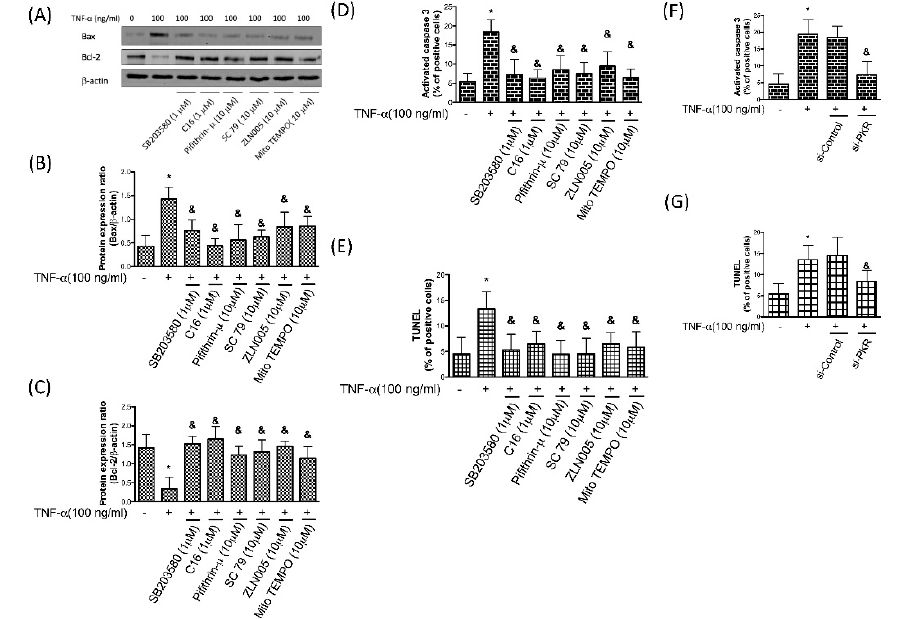
Figure 7. Protein expression ( A ) and ratio of Bax and Bcl2 ( B,C ) after TNF- α treatment in human chondrocytes in the presence of p38 inhibitor SB203580, PKR inhibitor C16, p53 inhibitor Pifithrin- μ , AKT activator SC79, PGC-1 α stimulator ZLN005, or superoxide scavenger Mito TEMPO. Percentages of TNF- α -stimulated caspase-3 activation ( D,F ) and TUNEL-positive cells ( E,G ) were evaluated in response to p38 inhibitor SB203580, PKR inhibitor C16, p53 inhibitor Pifithrin- μ , AKT activator SC79, PGC-1 α stimulator ZLN005, or superoxide scavenger Mito TEMPO. Percentages of TNF- α -stimulated caspase-3 activation ( C ) and TUNEL-positive cells ( D ) in normal, si-Control or si-PKR chondrocytes. n = 3; * p < 0.05 compared to control group. p < 0.05 compared to TNF- α group, p values were generated by ANOVA using the Tukey’s test.